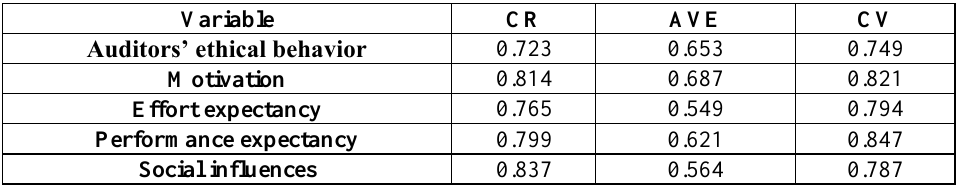
Table 1. Convergent validity and reliability of research